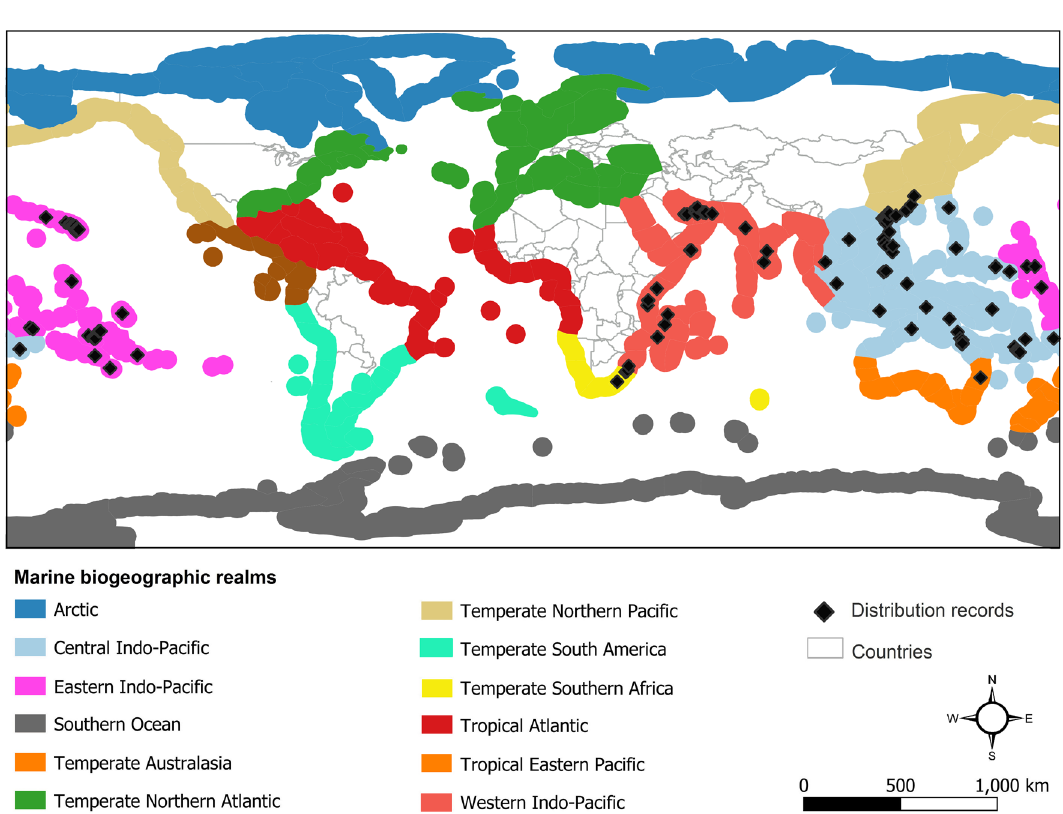
Figure 4. Global distribution of the Metopograpsus thukuhar / cannicci species complex and marine biogeographic realms 74 . The map was generated using QGIS 3.4.1 (https:// www. qgis.